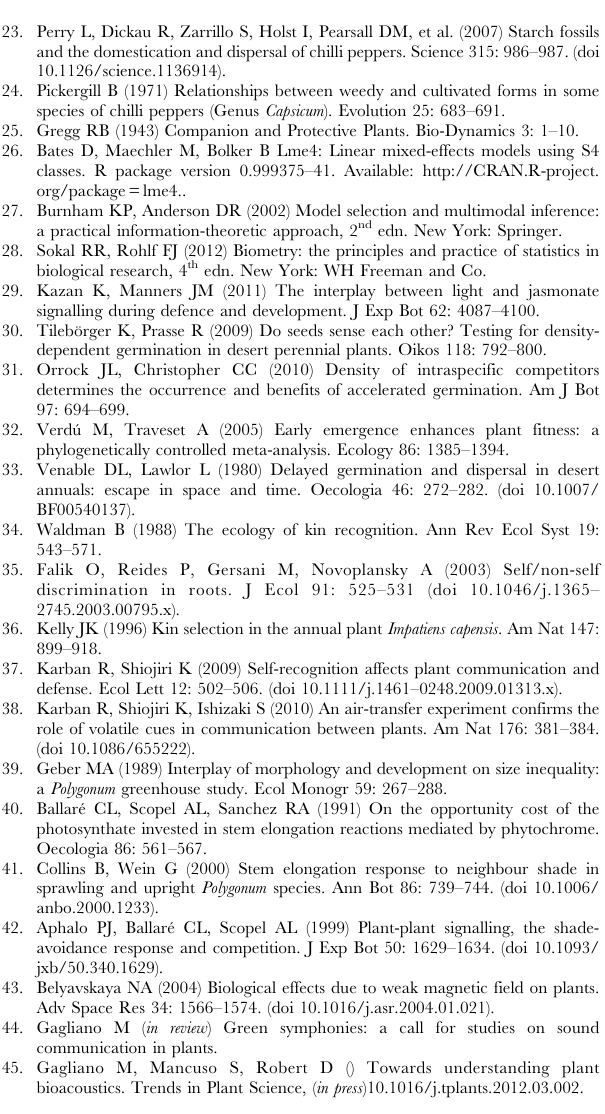
Figure S3 Germination of chilli seeds across treat- ments. Germination of chilli seeds is affected by the mere presence of an adult fennel plant. The percentage of seed germination over time is higher when the fennel is present but all known signals are blocked (grey boxes). The median, inter- quartile range and range are represented by the middle bar, the top and bottom of box and the whiskers respectively. Outliers laying more than 3 times the inter-quartile range from the median are represented by the small circles. Table S1 Tested effects in each treatment. The number 1 indicates that an effect was operating in a particular treatment, while the number 0 indicate it was not